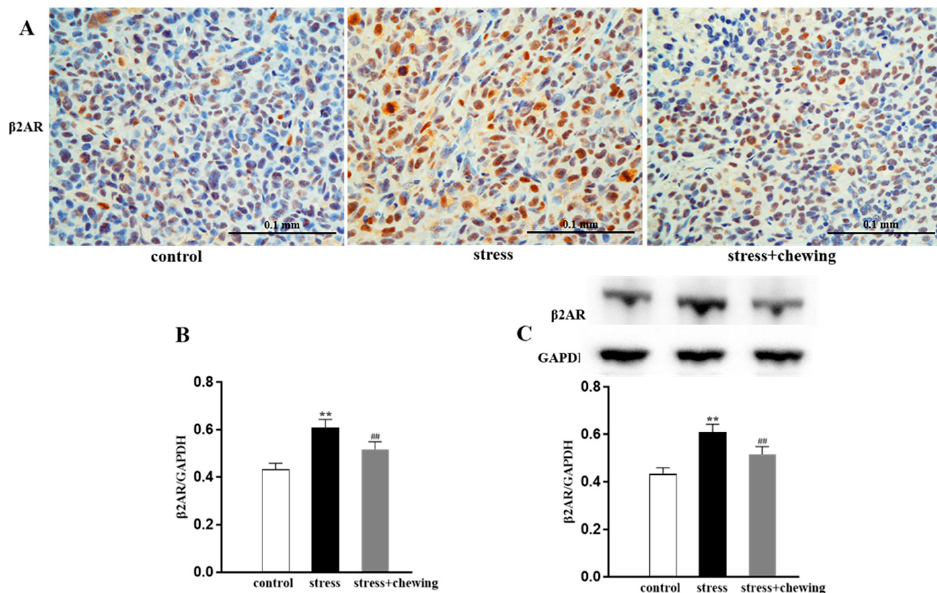
Figure 4. Chewing behavior during psychological stress decreased the expression of β 2AR in the tumor. ( A ) Representative photographs of β 2AR-positive cells in the tumor. ( B ) The percentage of β 2AR-positive cells in the tumor. ( C ) The expression level of β 2AR protein in the tumor. (** p < 0.01 vs. control group, ## p < 0.01 vs. stress group, n = 9/group). All data are expressed as mean ± SEM.